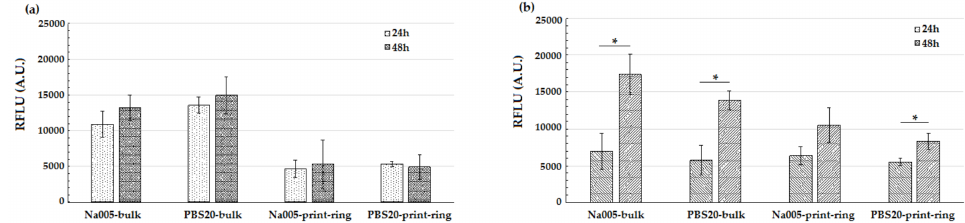
Figure 7. alamarBlue assay on MC-Na005 and MC-PBS hydrogel, bulk and printed ring specimens; cells were cultured on the specimens for 24 and 48 h. ( a ) NIH/3T3 fibroblast cells; ( b ) MS1 endothelial cells. (*): p < 0.05, comparing 24 versus 48 h of